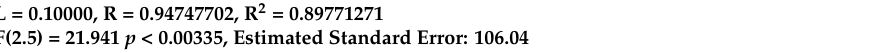
Table 4. Summary details of lambda ridge regression from the 1st study stage for female participants; dependent variable = ranking